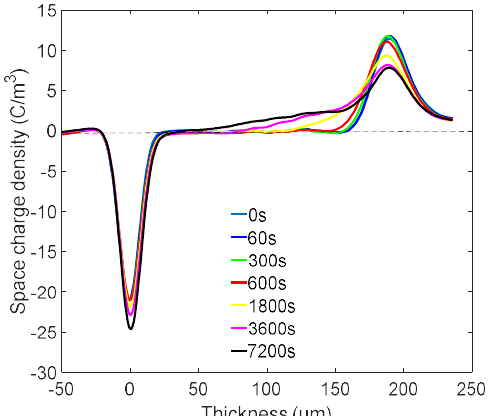
Figure 1. Pulsed electro-acoustic (PEA) measurement results in low density polyethylene (LDPE) film at 20 kV/mm field under room temperature.